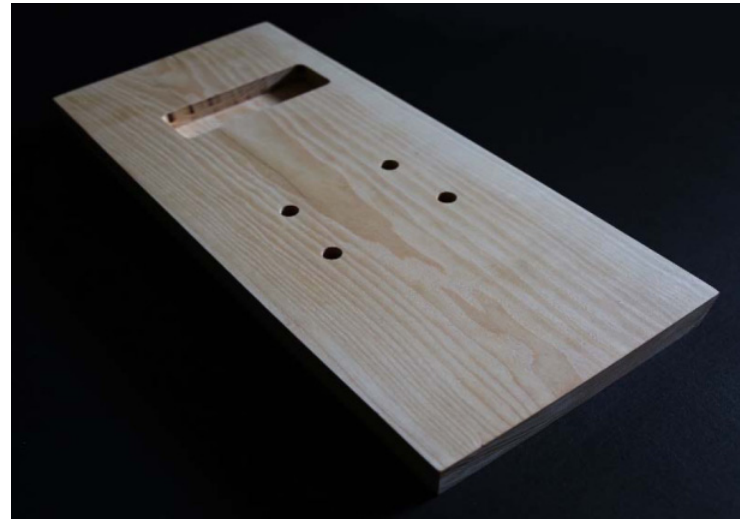
Figure 1. CNC-machined element of ash (A) ( Fraxinus excelsior L.) for the solid body of an electric guitar with holes for pickup, bridge and tailpiece [24]. Table 1. Mean acoustic quality indicators of ash (A) and walnut (W) wood, determined by flexural vibration of elements for electric guitar solid body: f 1 —fundamental frequency, tan δ —vibration damping, E / ρ —specific modulus of elasticity, K —acoustic coefficient, ACE —acoustic conversion efficiency and RACE —relative acoustic conversion efficiency (CV%—Coefficient of variation) [24].